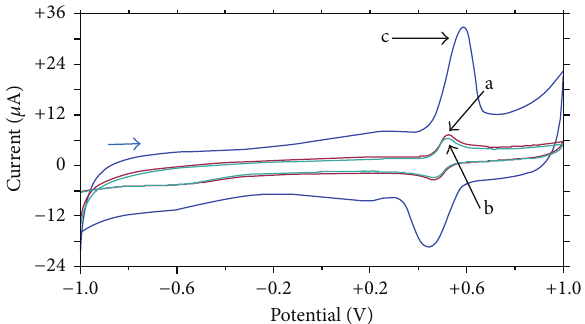
Figure 2: Cyclic voltammetry scanning of 0.1mM paracetamol in 0.1M KH 2 PO 4 at (a) bare GCE, (b) Ni-modified GCE, and (c) SWCNT/Ni-modified GCE versus Ag/AgCl. Scan rate: 100mVs −1 .